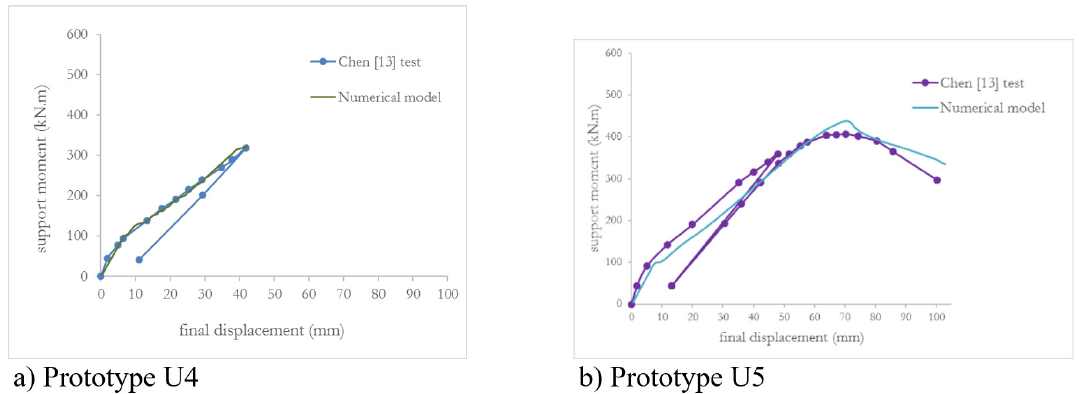
Figure 8. Vertical displacement at the free end of the composite beam.